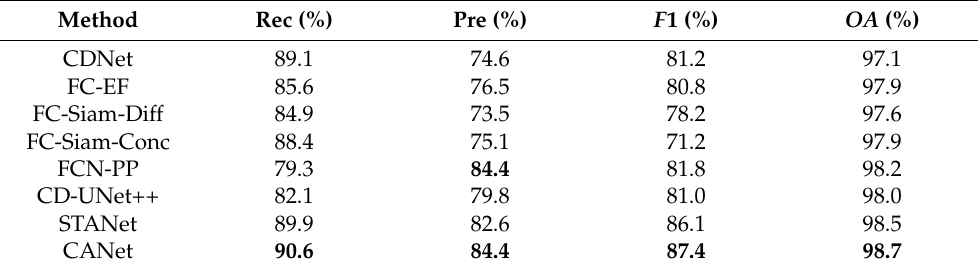
Figure 8. Visualization of eight different methods of CDD dataset: ( a ) represents T1 images; ( b ) represents T2 images; ( c ) label; ( d ) are results obtained by CDNet; ( e ) are results obtained by FC-EF; ( f ) are results obtained by FC-Siam-diff; ( g ) are results obtained by FC-Siam-conc; ( h ) are results obtained by FCN-PP; ( i ) are results obtained by CD-UNet++; ( j ) are results obtained by STANet; ( k ) are results obtained by CANet. Table 4. Comparison of LEVIR-CD dataset results. (The best performance is emphasized in bold.).